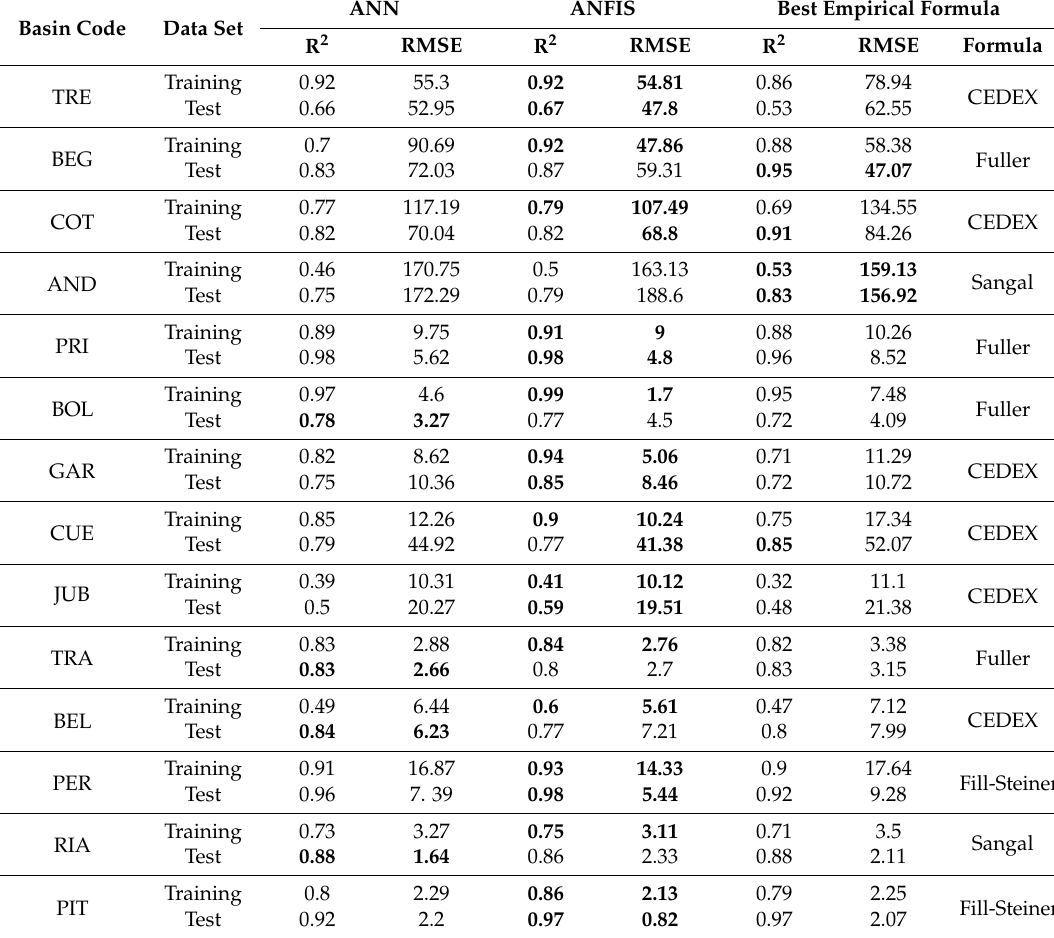
Table 4. Statistics of artificial neural networks (ANN), adaptive neuro-fuzzy inference (ANFIS) versus the best empirical